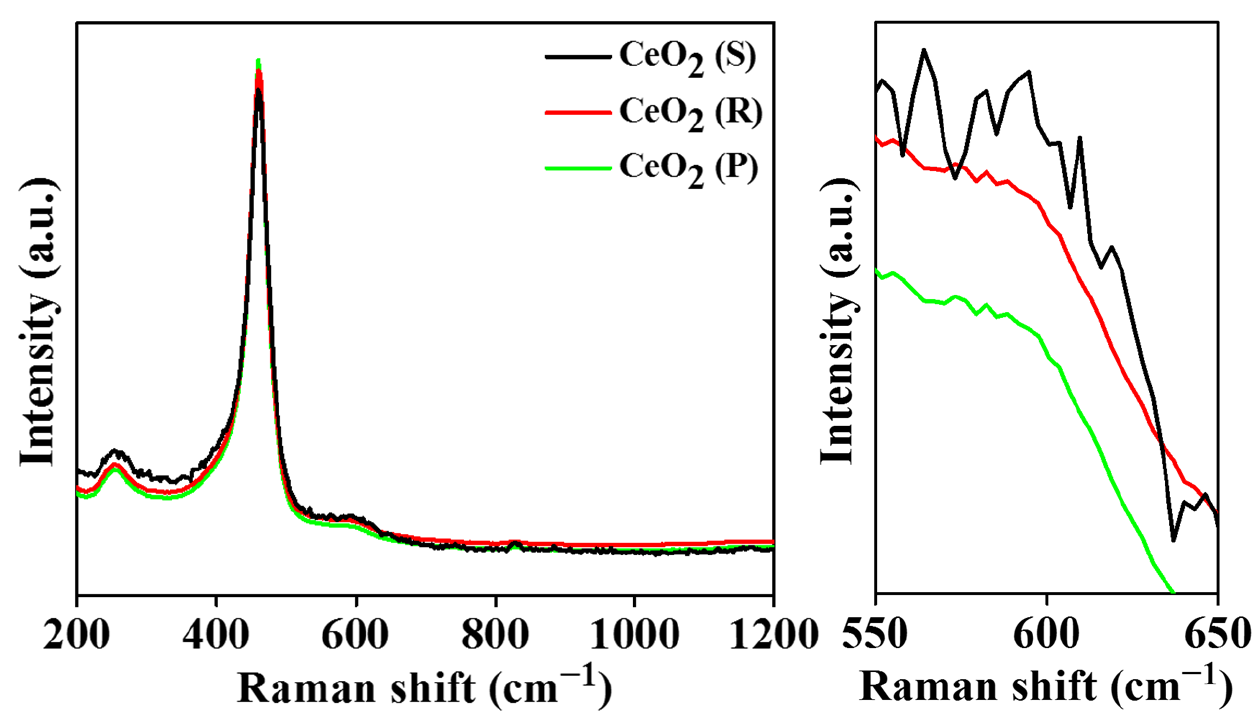
Figure 2. Raman spectra of CeO 2 (S), CeO 2 (R) and CeO 2 (P).